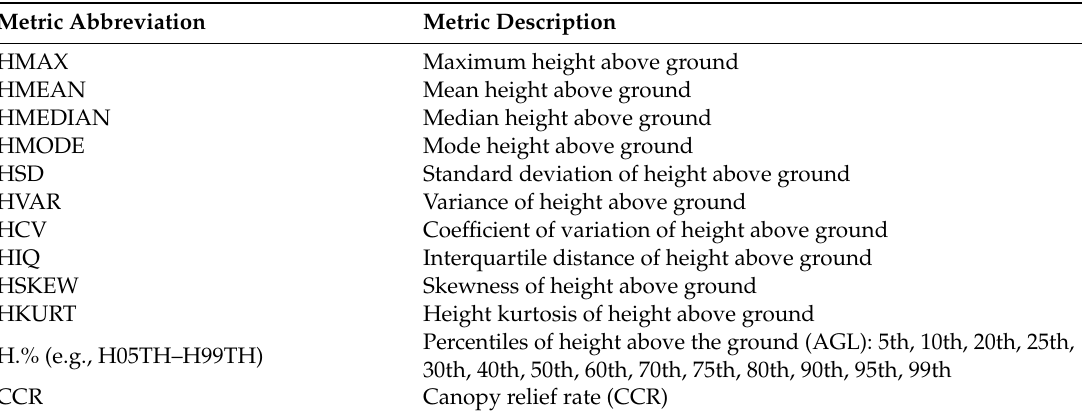
Table 3. LiDAR-derived forest structure